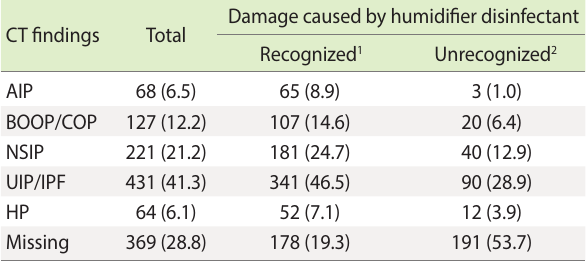
Table 2. CT findings for interstitial lung disease according to